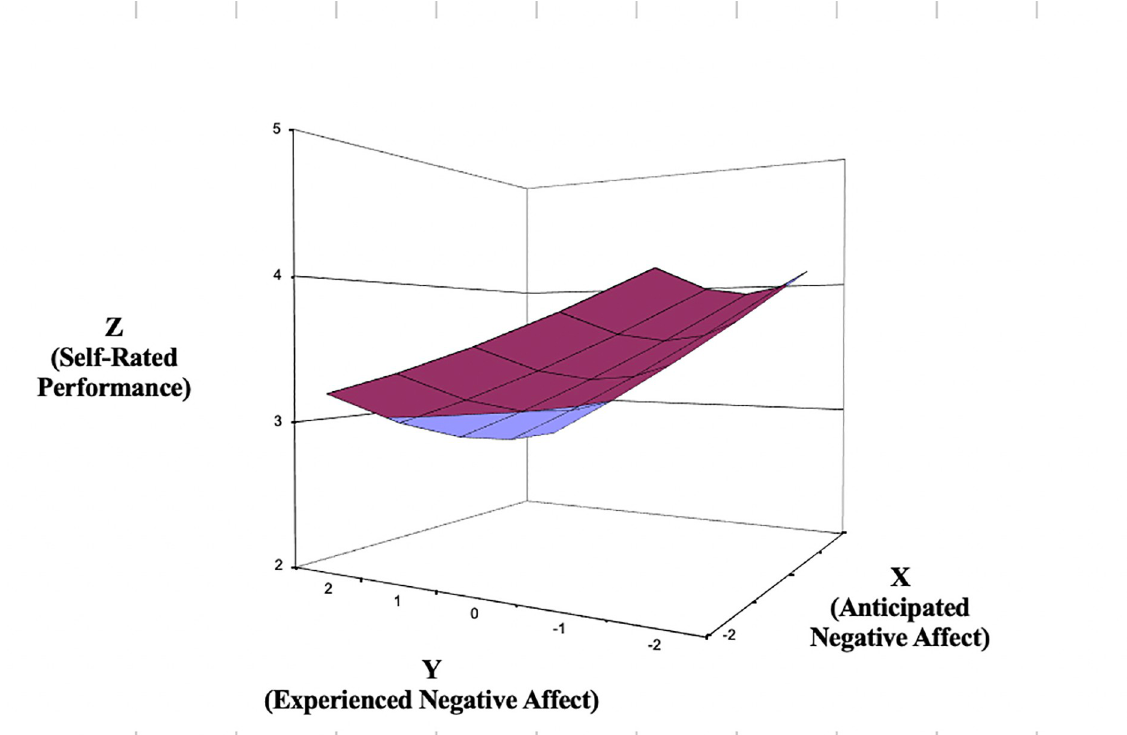
Fig 3. Response surface area wherein self-reported performance is predicted by the anticipated—experienced negative affect discrepancy (Study 1).